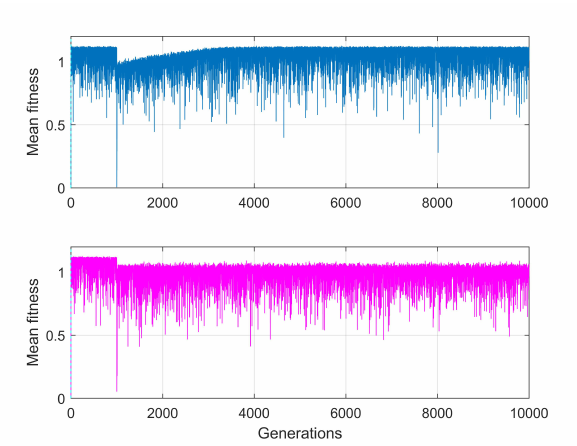
Figure 5: Mean fitness plots corresponding to the step response plots in Figure 3. The upper figure shows mean fitness for G cc = 0 . 5, while the lower figure is for G cc = 0. The maximum fitness in eq. (16) is set to W max = 1 . 2, such that the mean fitness with G cc = 0 . 5 over time is approximately 1, which means that the population size is